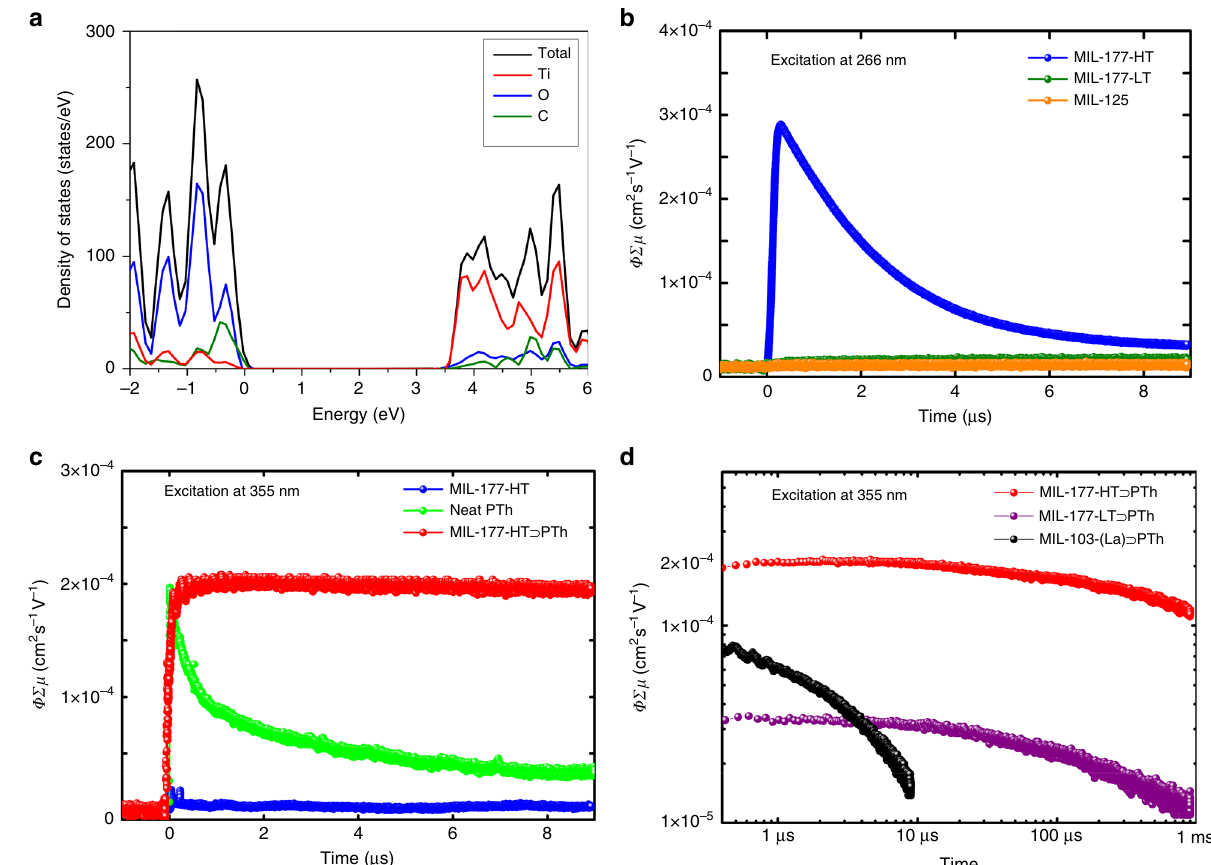
Fig. 5 Physical properties of MIL-177 and related composites. a Total and partial PDOS of MIL-177-HT calculated at the PBEsol level to determine the contribution of the different orbitals. b Conductive transients observed by FP-TRMC upon excitation at 266 nm with a UV laser (MIL-177-HT in blue, MIL- 177-LT in green and MIL-125 in orange); c Conductive transients observed by FP-TRMC under 355 nm near-UV irradiation (MIL-177-HT ⊃ PTh in red, MIL- 177-HT in blue, and neat PTh in light green); d Conductive transients observed by FP-TRMC under 355 nm near-UV irradiation showing the extremely long lifetime of MIL-177-HT ⊃ PTh (>1 ms, in red) with MIL-177-LT ⊃ PTh in purple and MIL-103(La) ⊃ PTh in black for